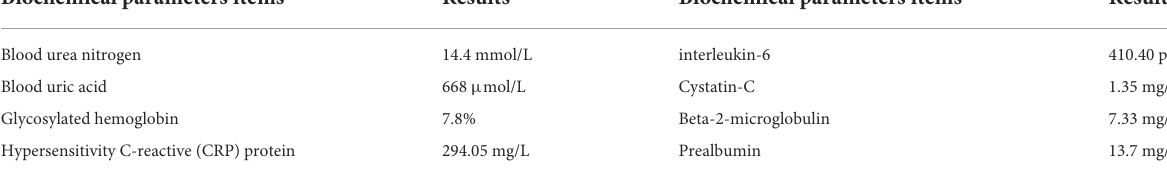
TABLE 2 Trends in inflammatory indicators during the patient’s hospitalization.